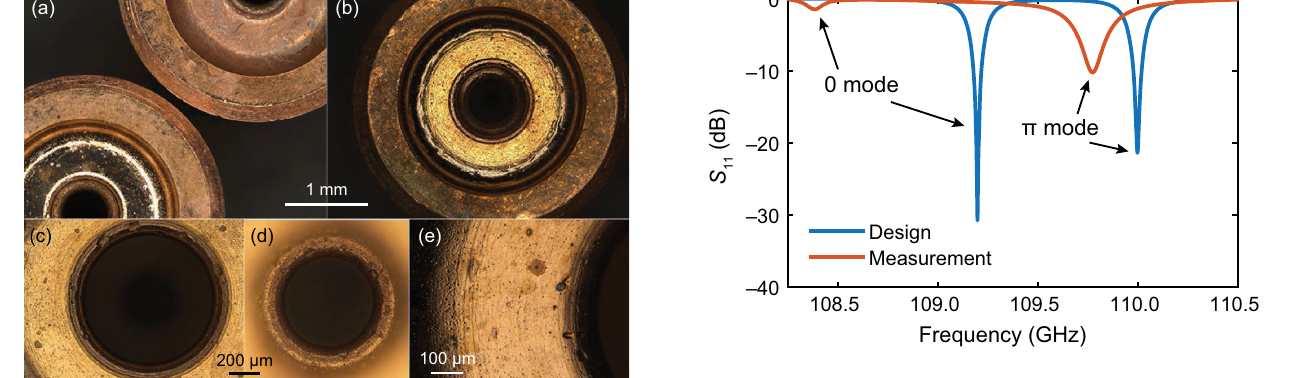
FIG. 10. An example measurement of the reflection signal ( S 11 ) compared to the design. The 0 mode and π mode are indicated. In the fabricated structures, both modes are lower in frequency than the design. There is also a clear difference in the relative strength of the two modes and their spacing.